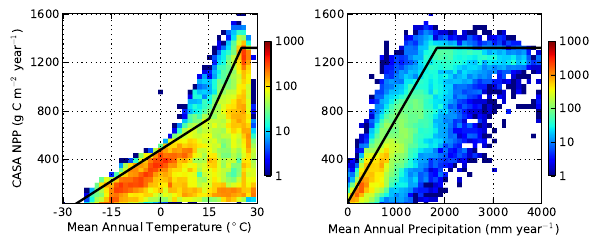
Fig. 2. CASA-predicted net primary production (NPP) against mean annual temperature (MAT, left) and precipitation (MAP, right) for all terrestrial 0.5 ◦ grid cells. The color scale indicates the number of 0.5 ◦ grid cells corresponding to NPP, MAP, and MAT bins. Black lines correspond roughly to 90th